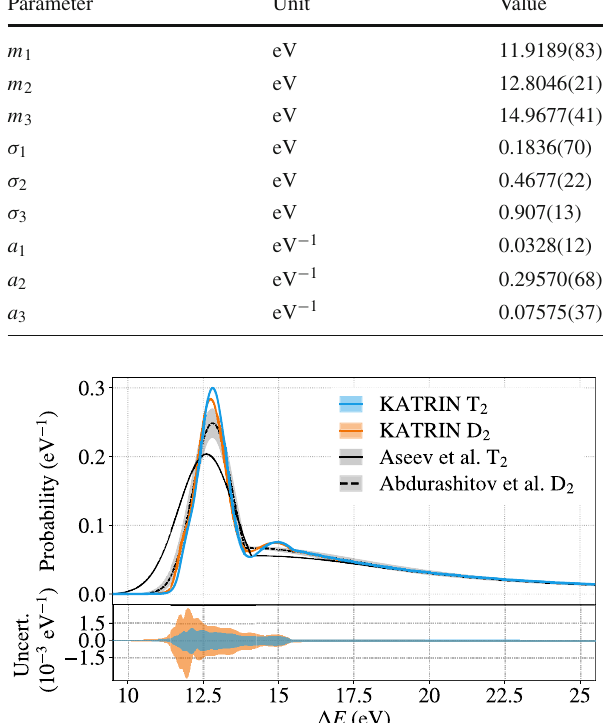
Table 2 Best-fit parameters for the energy-loss function in molecular tritium as described in Eq. (2). Parameter correlations are provided as a covariance matrix in Table 5 in the Appendix Parameter